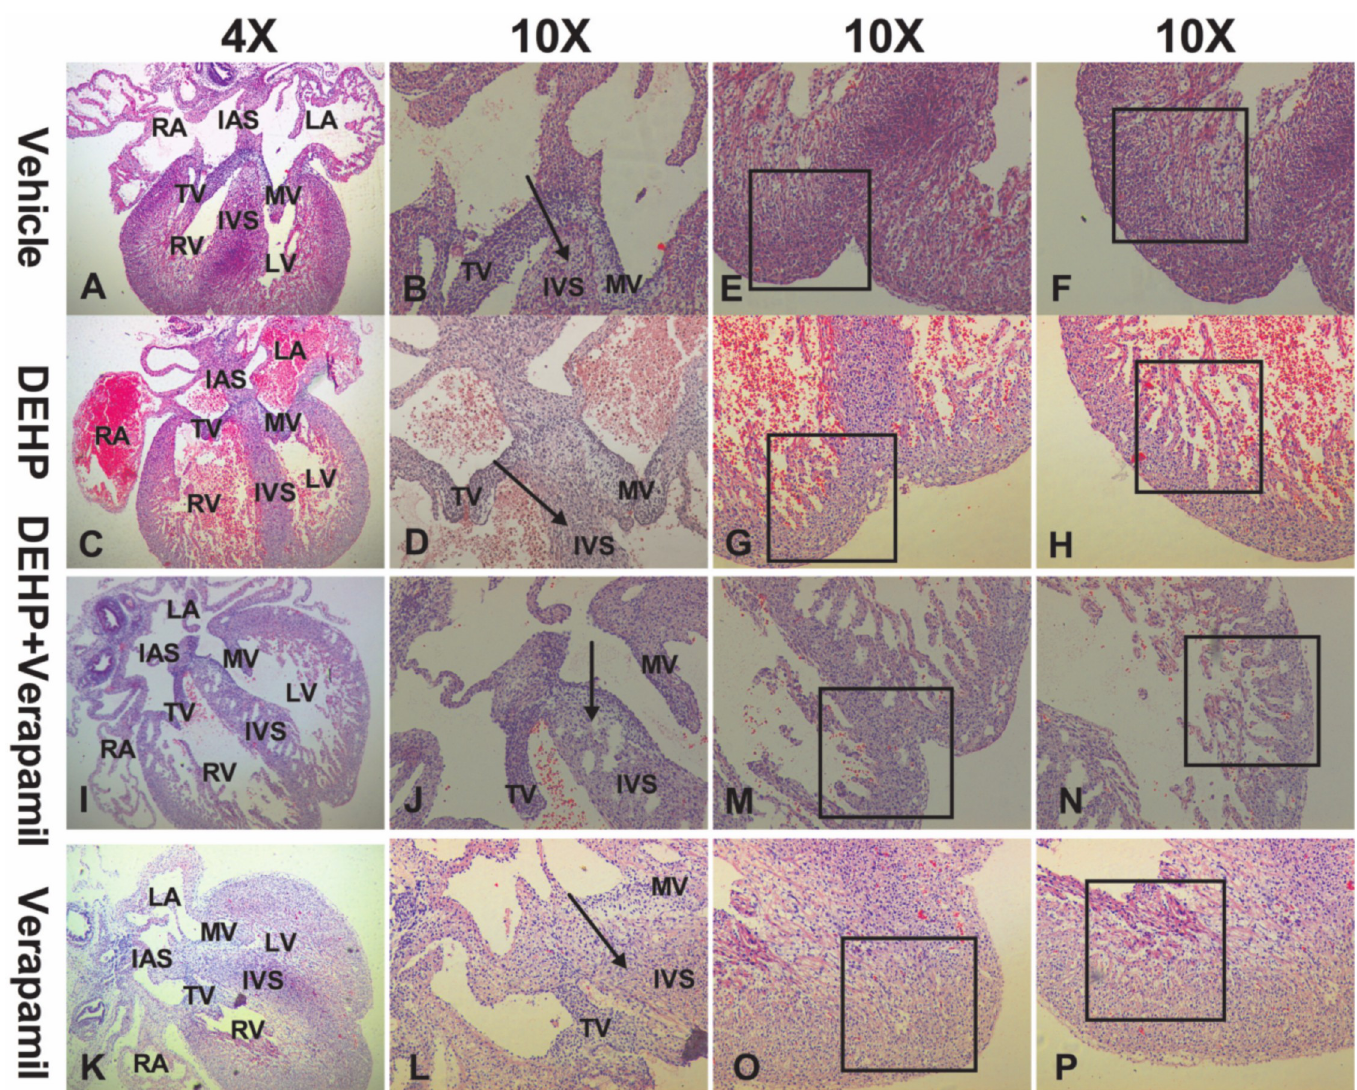
Fig 3. Fetal cardiac malformations induced by maternal Di-(2-ethylhexyl)-phthalate (DEHP) and verapamil exposure from E6.5 to E14.5. The phenotype of fetal cardiac malformations included ventricular myocardium noncompaction (G, H, M, N). The magnification used was 4 × and 10 × .